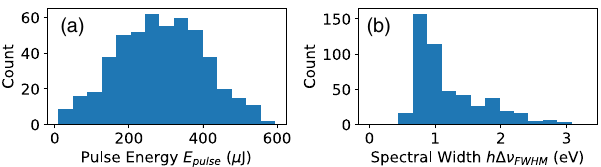
FIG. 13. Statistics of 500 shots of experiment data of Ref. [11]. (a) and (b) show histograms of the pulse energies E FWHM spectral widths h Δ ν